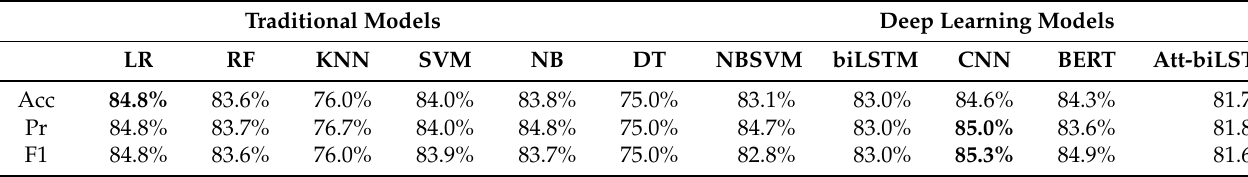
Table 7. Performance of models on the binary classification task (agree and disagree classes). Bold values indicate the highest